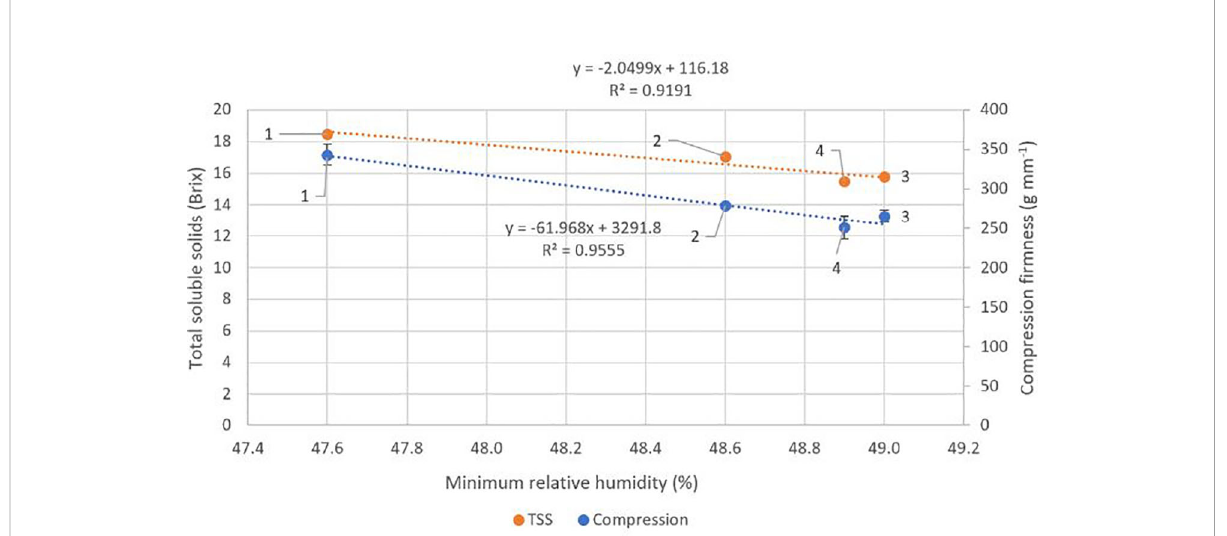
FIGURE 4 Effect of mean minimum relative humidity at each of the four locations across an altitude/distance from PCS boundary gradient on mean fruit compression fi rmness and mean total soluble solids (TSS). At each location n = 60, 30 fruits per tree. Bars represent one standard error for each location. PCS, protected cropping